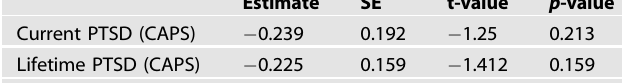
Stress and trauma are associated with accelerated epigenetic age across multiple psychiatric conditions, including MDD and PTSD [38]. To identify if diminished levels of TRECs are also associated with acceleration of epigenetic age in the overall sample, we tested correlations between TREC levels and six epigenetic age accelera- tion measures. Remarkably, TREC levels strongly negatively correlate with HannumAge acceleration (R = − 0.21, p < 0.001) (Fig. 4A), PhenoAge acceleration (R = − 0.29, p < 0.001) (Fig. 4B), and extrinsic epigenetic age acceleration (EEAA) (R = − 0.28, p < 0.001) (Fig. 4C), all of which are endpoints that re fl ect immune system aging. Levels of TRECs did not correlate with DNAmAge acceleration (Fig. 4D), GrimAge acceleration (Fig. 4E), and intrinsic epigenetic age acceleration (IEAA) (Fig. 4F). Of these endpoints, DNAmAge acceleration and IEAA calculate DNAmAge acceleration independent from changes in blood composition that are characteristic of immune system aging. In general, these signi fi cant correlations between levels of TRECs and measures of accelerated methylation age were maintained in sex-strati fi ed analyses